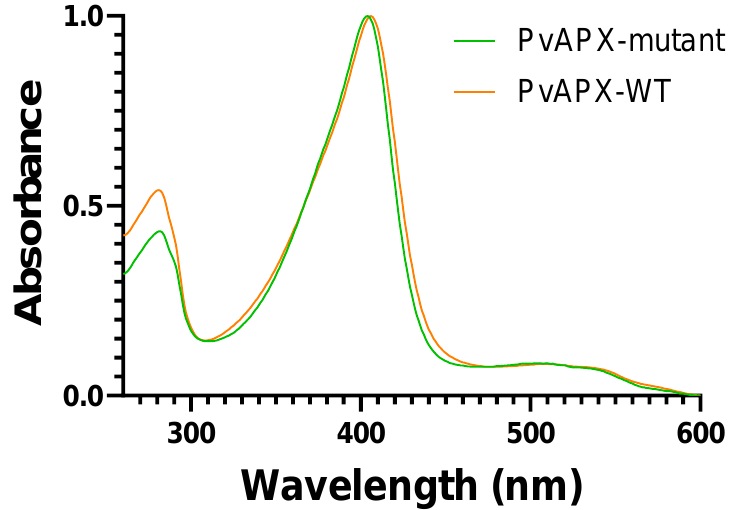
Figure 1. Spectrum of purified wild-type and mutant PviAPXs. The spectrum was recorded with 5 μM of PviAPX at room temperature. The spectrum was normalized to have OD 404 equal to one. The spectrum was collected in the range of 260 to 600 nm.